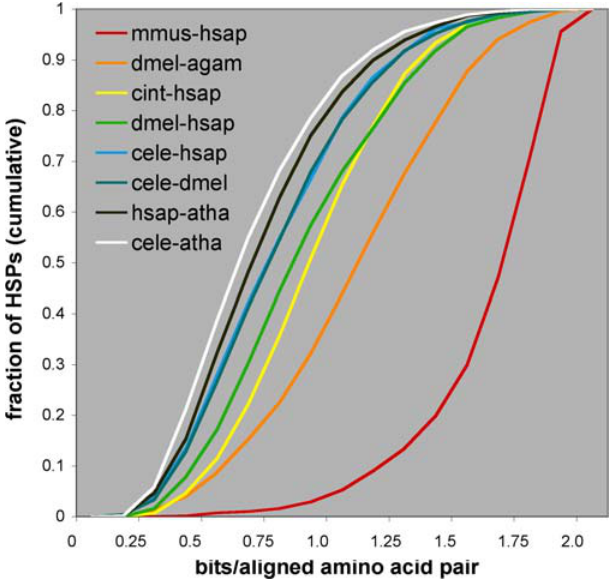
Figure 2. Cumulative Distribution Functions Illustrating Proteome-Wide Trends in Protein Similarity x -axis, bits/aligned position; y -axis, cumulative fraction of HSPs having that number of bits/aligned amino acid pair or less. To facilitate display, only a subset of the 21 possible pair-wise combinations is shown. Data are based upon all reciprocal best BLASTP hits identified in all versus all BLASTP searches of the proteomes. Similarity calculations were restricted to the high-scoring HSP for each BLAST hit, in order to avoid data duplication due to overlapping alignments. There were 13,339 M. musculus–H. sapiens reciprocal best hits; 6,435 between D. melanogaster and A. gambiae; 5,828 between C. intestinalis and H. sapiens; 5,542 between D. melanogaster and H. sapiens; 4,669 between C. elegans and H. sapiens; 4,588 between C. elegans and D. melanogaster; 3,361 between H. sapiens and A. thaliana; and 2,835 between C. elegans and A. thaliana . atha, A. thaliana; cele, C. elegans; cint, C. intestinalis; dmel, D. melanogaster; hsap, H. sapiens; mmus, M. musculus. DOI: